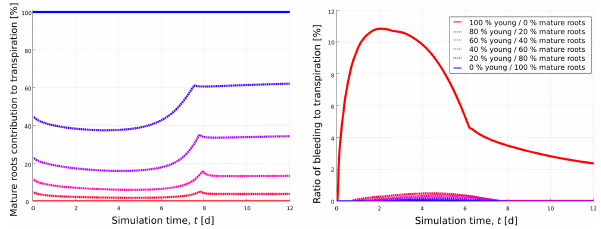
Figure 8. Evolution of mature root contribution to overall transpira- tion (left) and the ratio of bleeding (right) over time in the fixed root geometry for the six different hydraulic parameterizations. Results are obtained with the “aRoot” model for fractions of apical young roots between 0 and 100%. Homogeneous root systems are de- picted in solid lines; heterogeneous root systems are depicted with dashed